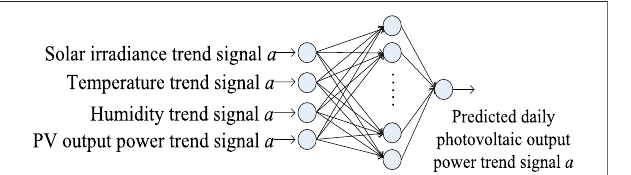
FIGURE 2 | Trend signal of LSSVM algorithm prediction